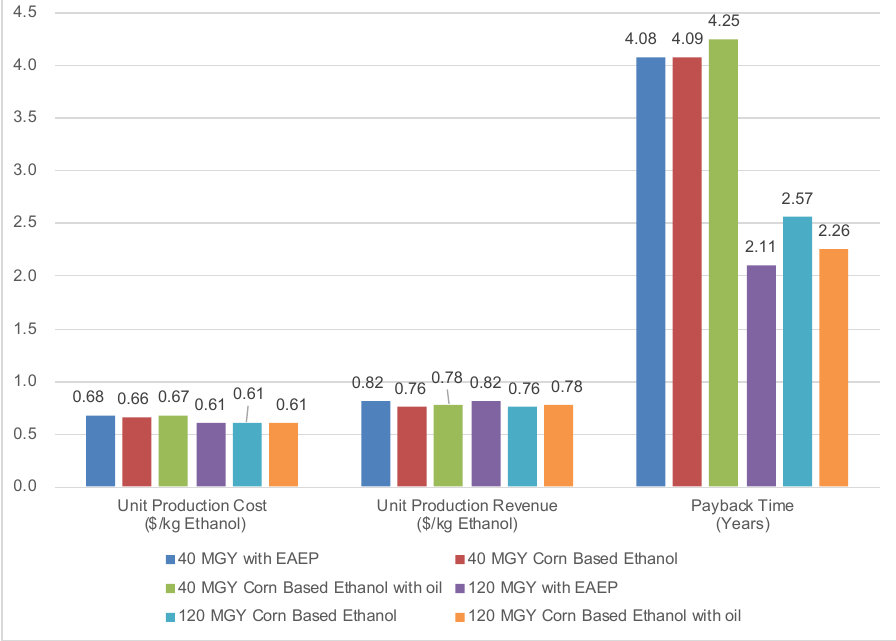
Figure 7. Unit analysis and payback time for integrated corn-soy ethanol fermentation processing. Scenarios include a 40 million gallon per year (MGY) ethanol plant with or without corn oil separation, a 120 MGY ethanol with or without corn oil separation, and a 40 or 120 MGY ethanol plant, without corn oil separation but with EAEP products used for fermentation.